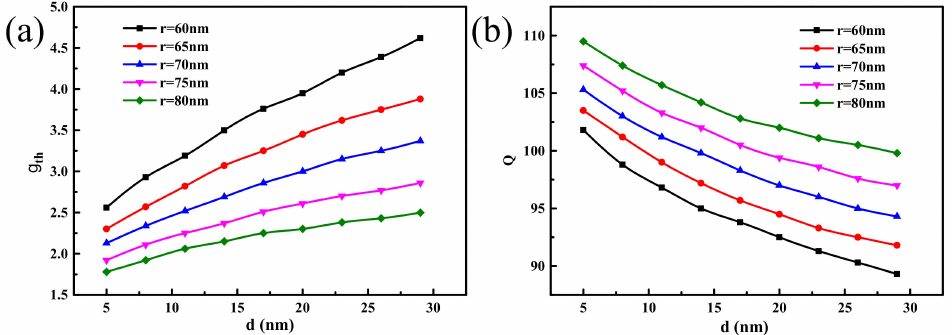
Figure 8. The change of ( a ) gain threshold g th and ( b ) quality factor Q with the nanowire radius r and dielectric layer thickness d